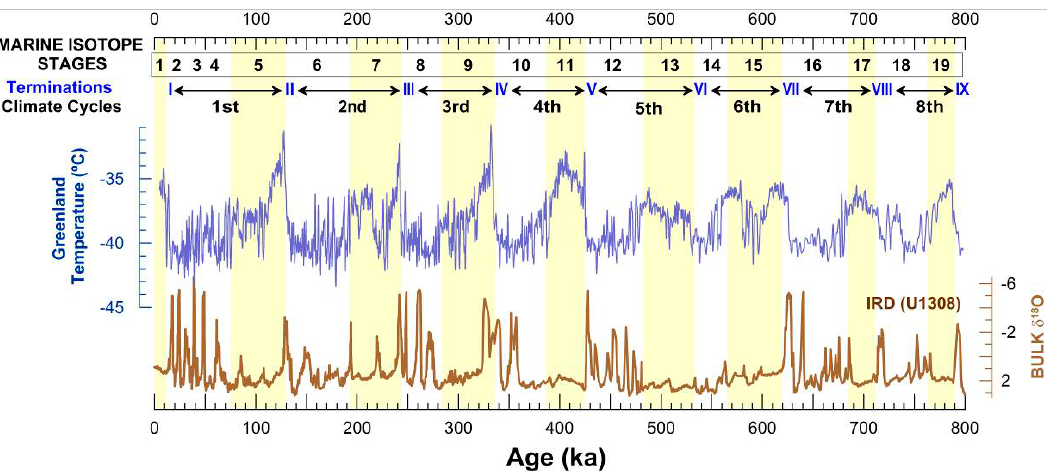
Figure 3. Temperature reconstruction for Greenland [37], compared with the occurrence of Heinrich Events, as indicated by the Ice Rafted Debris (IRD) record from the North Atlantic site U1308 (49°52.67’ N, 24°14.3’ W) [25]. Marine isotope stages, Terminations (in roman numerals), and climate cycles are represented on top. Yellow bands highlight interglacial stages.